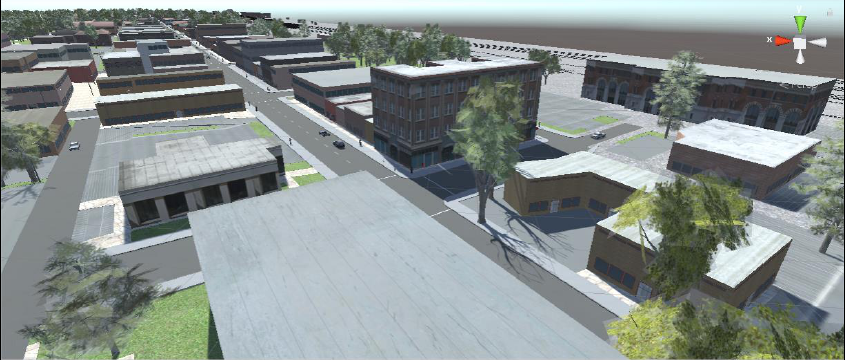
Figure 7. CityEngine model showing Hotel Yellowstone and the Union Pacific Railway Station.